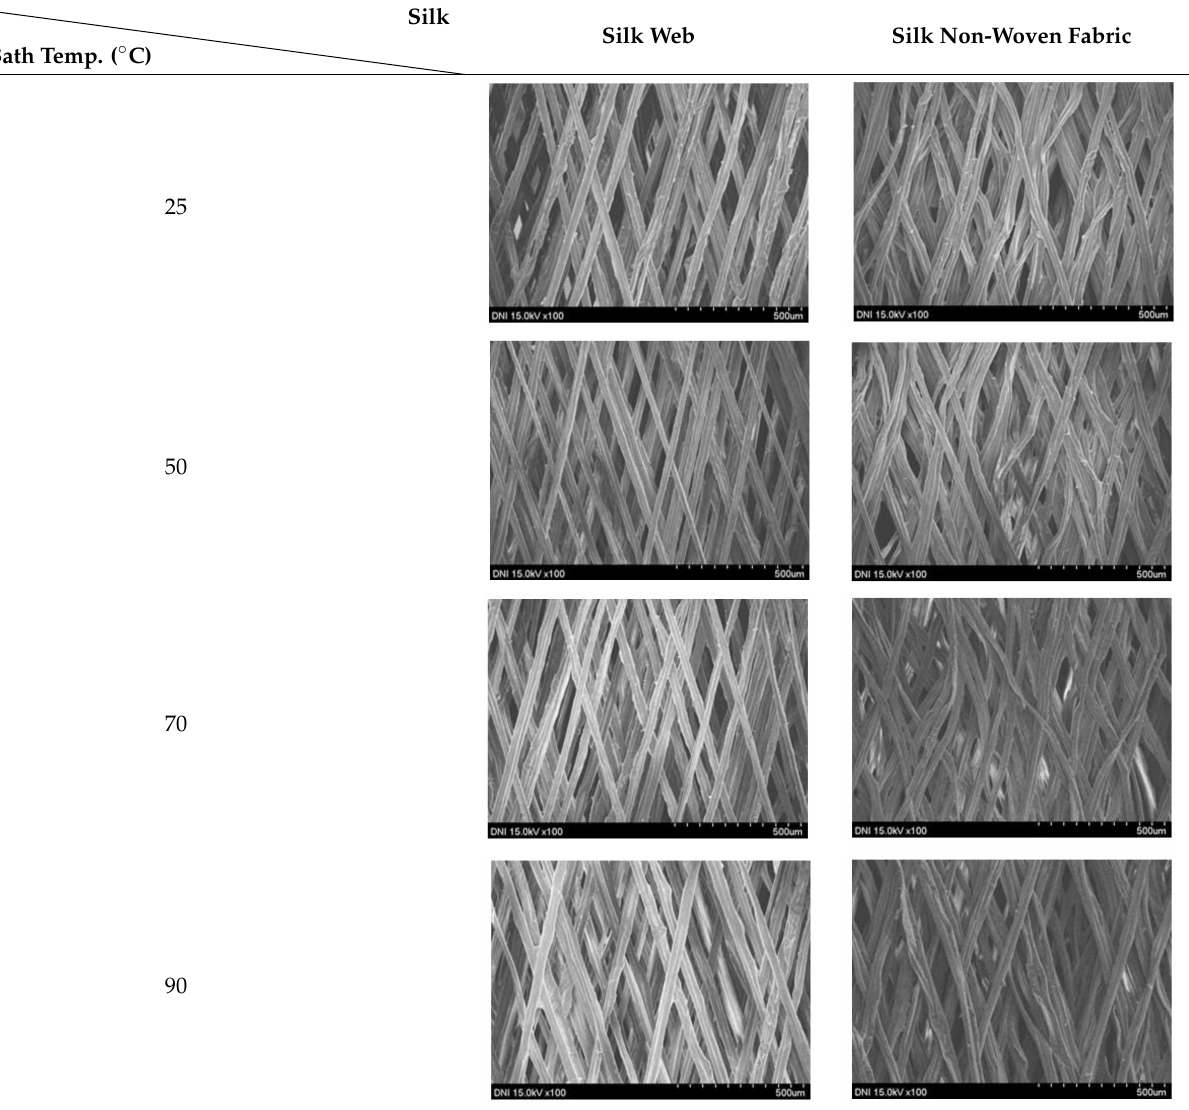
Table 4. FE-SEM images of silk web and silk non-woven fabrics prepared at various reeling bath temperatures. Reeling velocity was 39.2